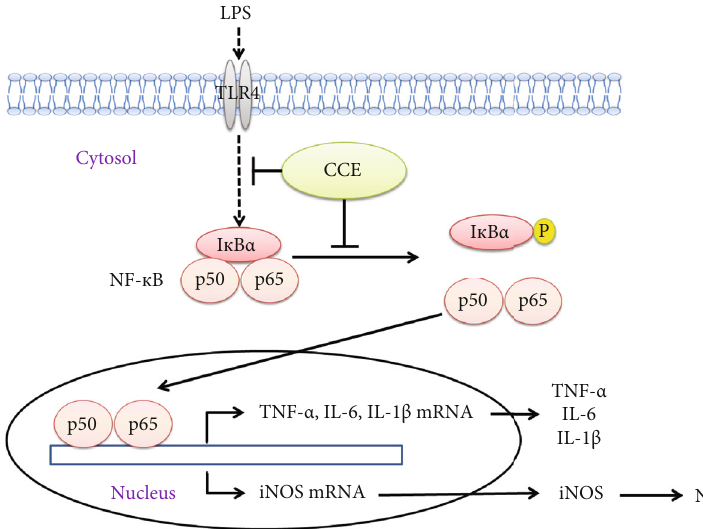
Figure 7: Mechanism of Commelina communis extract- (CCE-) induced suppression of lipopolysaccharide- (LPS-) mediated in fl ammatory reactions in RAW 264.7